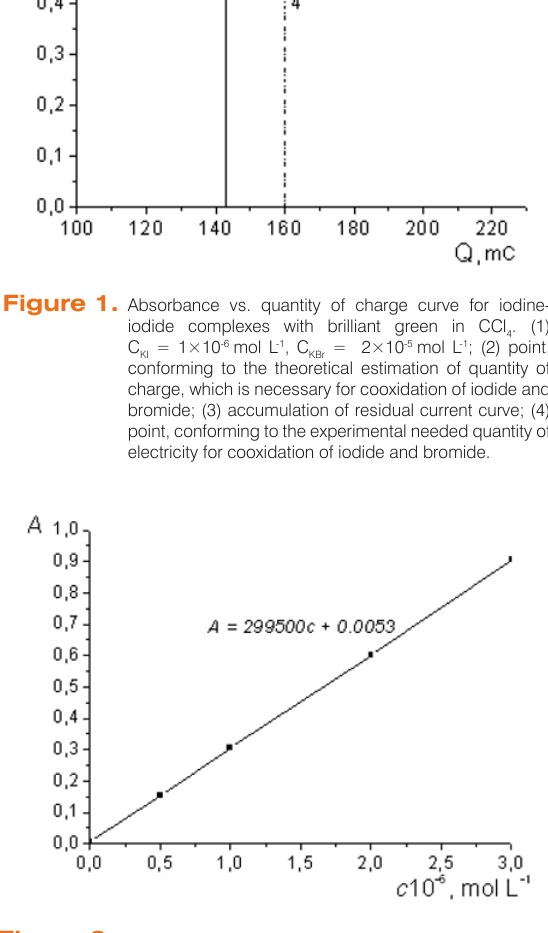
Figure 2. Calibration curve of the dependence of the absorbance of ionic associates of iodine-iodide complexes with brilliant green on concentration of iodide-ions in the electrochemical Fig. 2. The curve was plotted from data obtained after subtraction of the absorbance of the blank test. Values of the absorbance of the blank test were measured in the presence of 0.1 mol L -1 sulphuric acid solution. The value of the absorbance of the blank experiment is in the range of 0.080 – 0.082. Slope of the calibration curve is a = 300000 L mol -1 cm -1 and it exceeds 3ε(R + ). This is